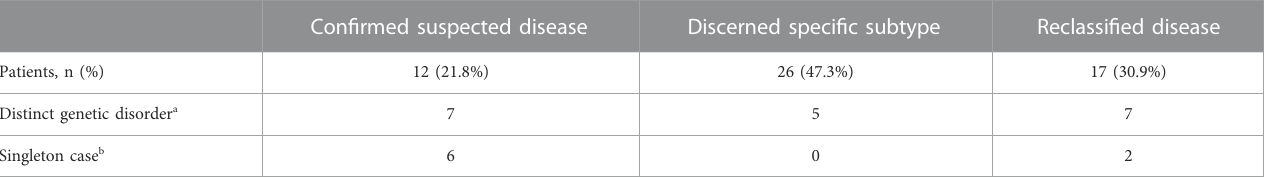
TABLE 4 Diagnostic utility in 55 patients with genetic diagnosis of